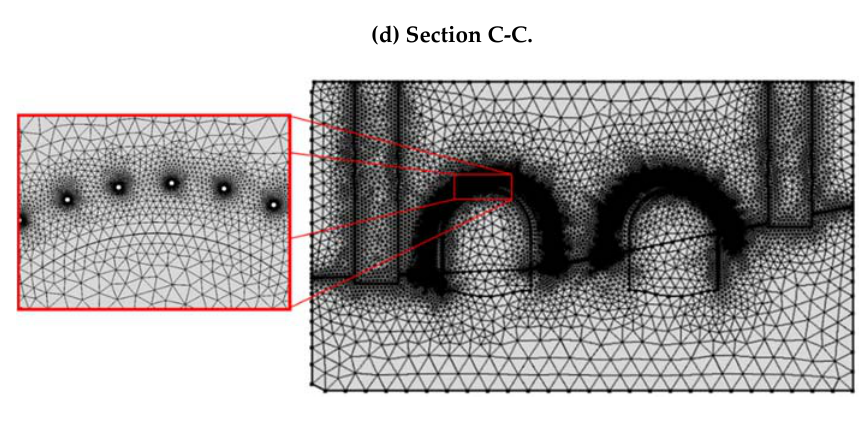
Figure 11. from (a) to (d): Temperature field below –2 °C after 14 days of AGF with liquid nitrogen in Figure 11. From ( a – d ): Temperature field below − 2 ◦ C after 14 days of AGF with liquid nitrogen in the the three sections of the odd tunnel reported in Figure 3; (e) detail of the employed mesh. three sections of the odd tunnel reported in Figure 3; ( e ) detail of the employed